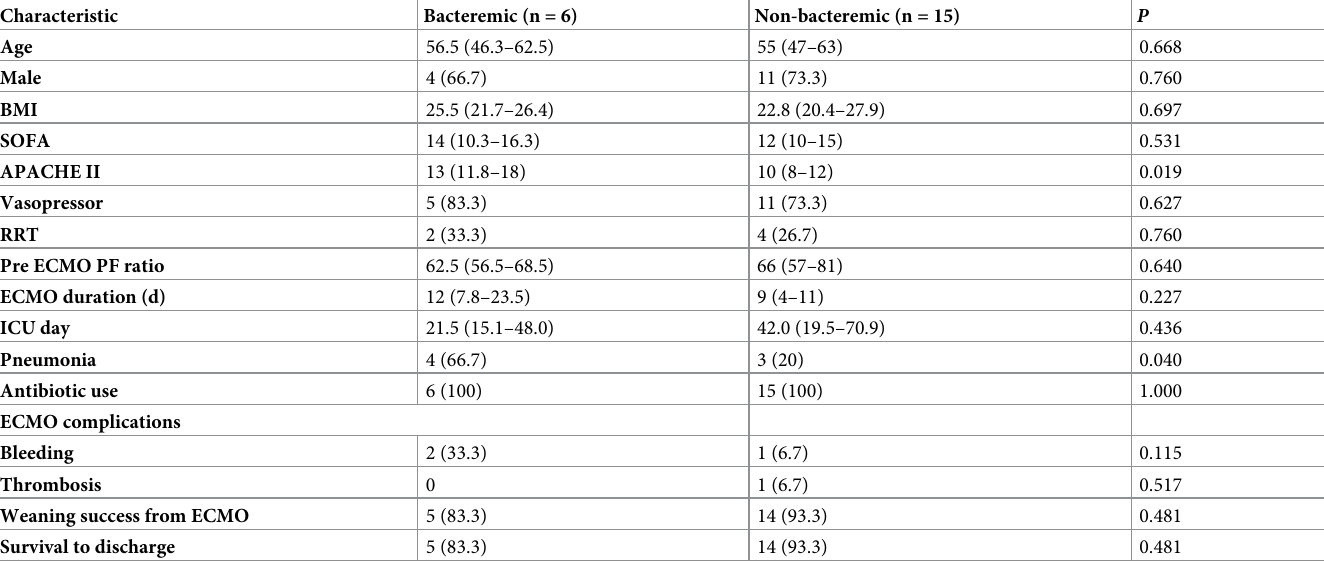
Table 1. Patient characteristics.